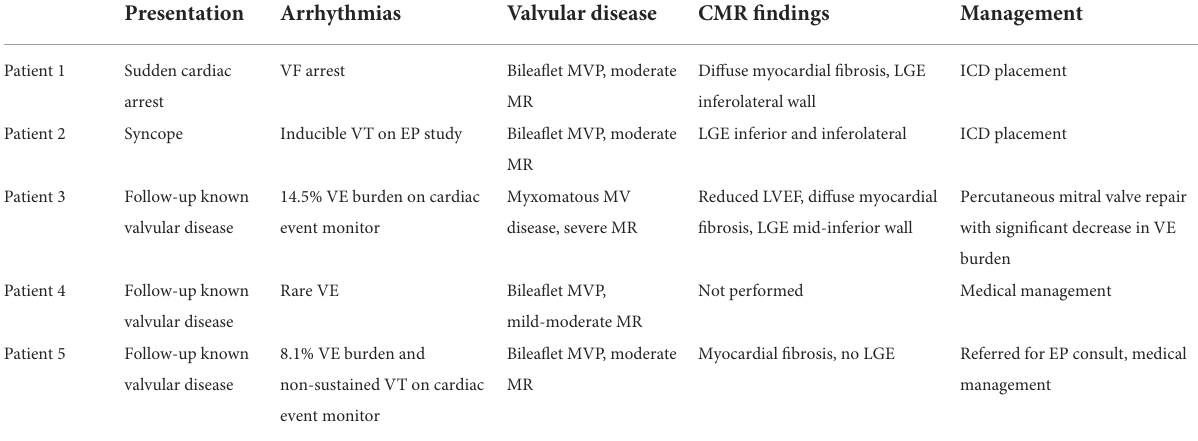
TABLE 1 Summary table of clinical features of 5 MAD